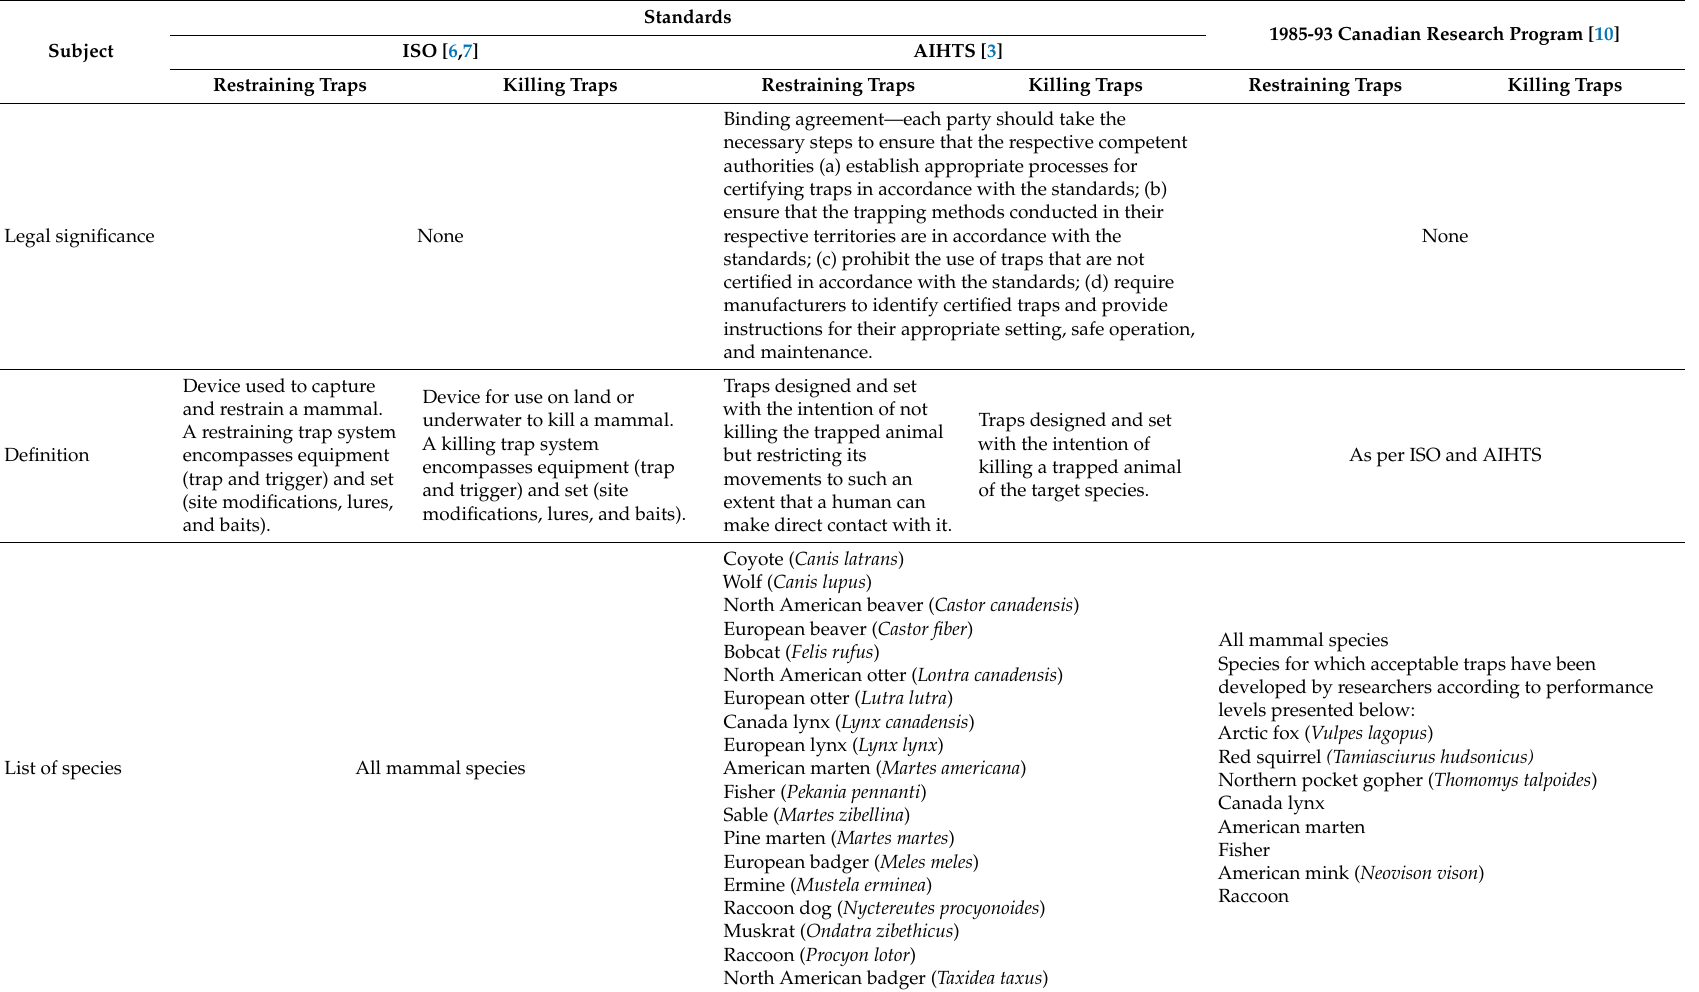
Table 1. Comparison of International Organization for Standardization (ISO) and Agreement on International Humane Trapping Standards (AIHTS) (excerpts from the original documents) to a Canadian research protocol conducted in parallel with the development of the